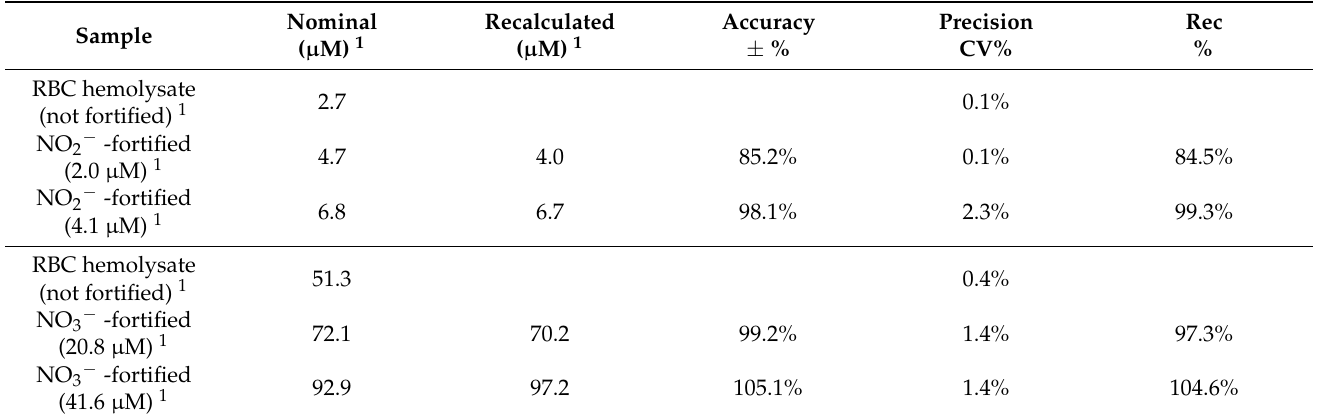
Table 5. The recovery of nitrite and nitrate in human red blood cells